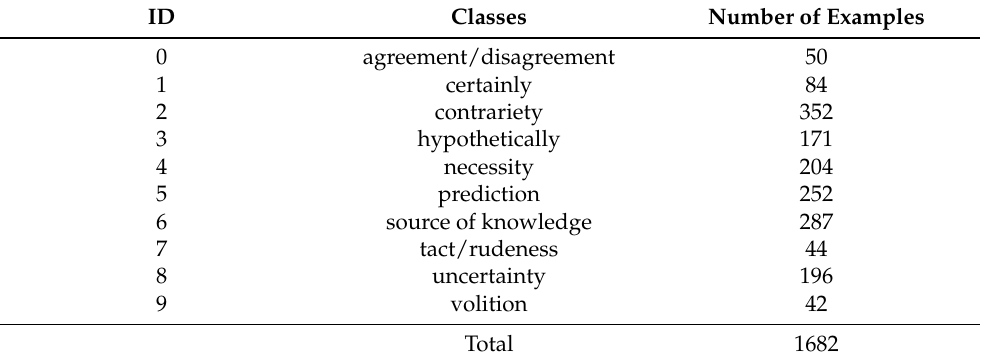
Table 3. Brexit Blog Corpus